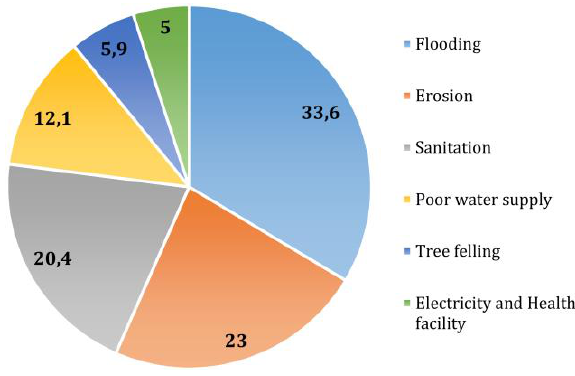
Fig. 5. Environmental challenges within the study area